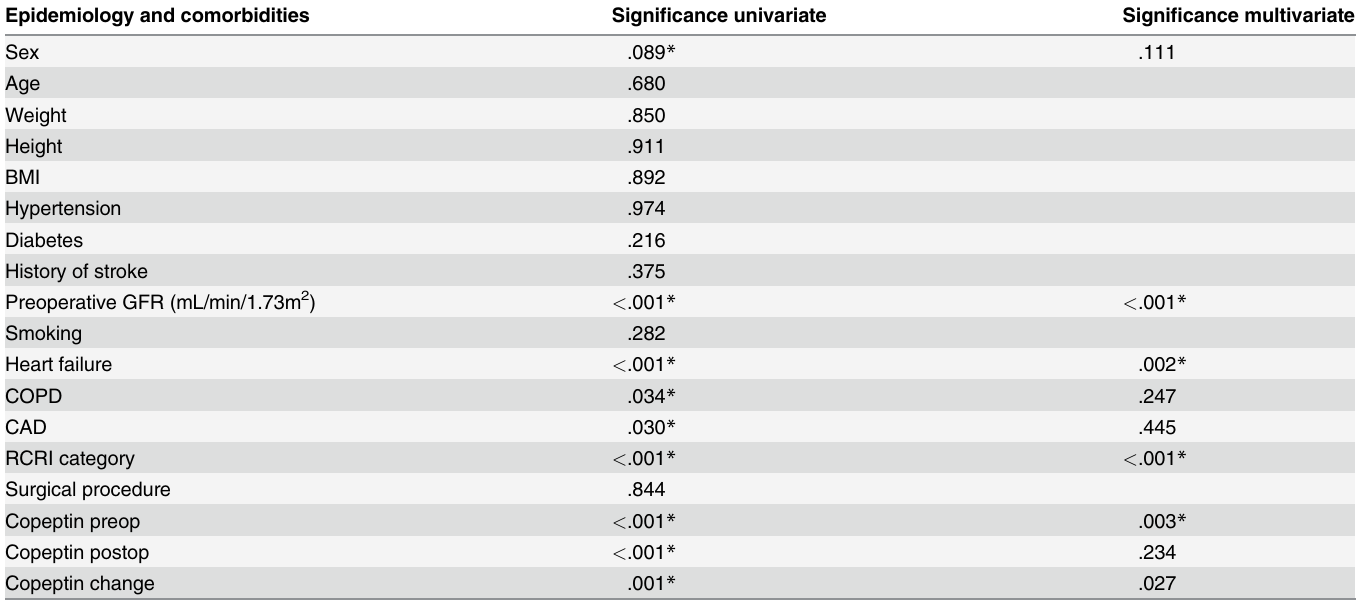
Table 2. Linear regression analysis of MACE and existing